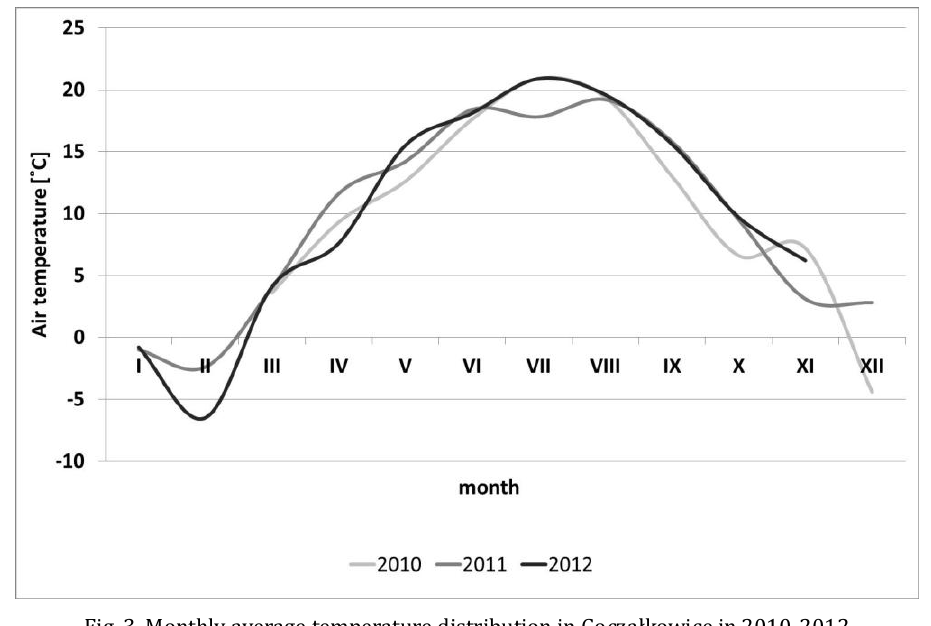
Fig. 3. Monthly average temperature distribution in Goczałkowice in 2010-2012